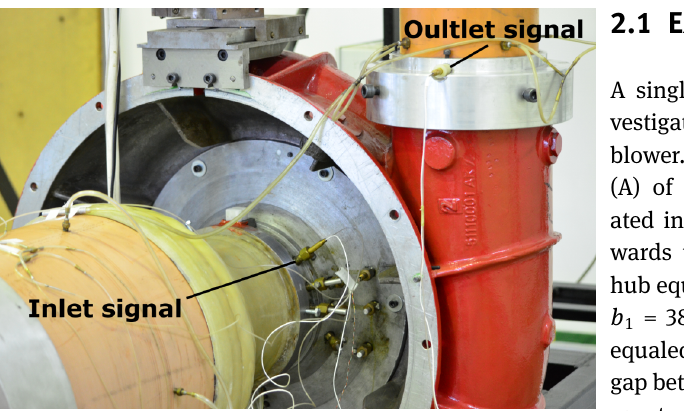
signal is presented in the phase space constructed from derivatives [16] or by the method of delays [17]. Time series is plotted in the phase space, which reveals cyclic behavior characteristic for particular state of the machine. For ex- ample, the phase portrait of the rotating stall was observed by Palomba and Breugelmans [18] and Palomba et al. [19]. to predict the surge